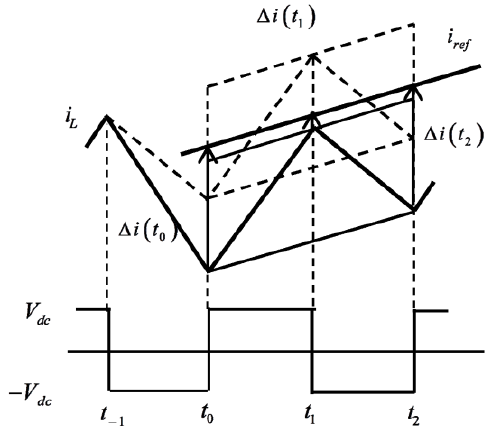
Figure 6. Conventional adaptive hysteresis current control does not guarantee the stability of the response current.